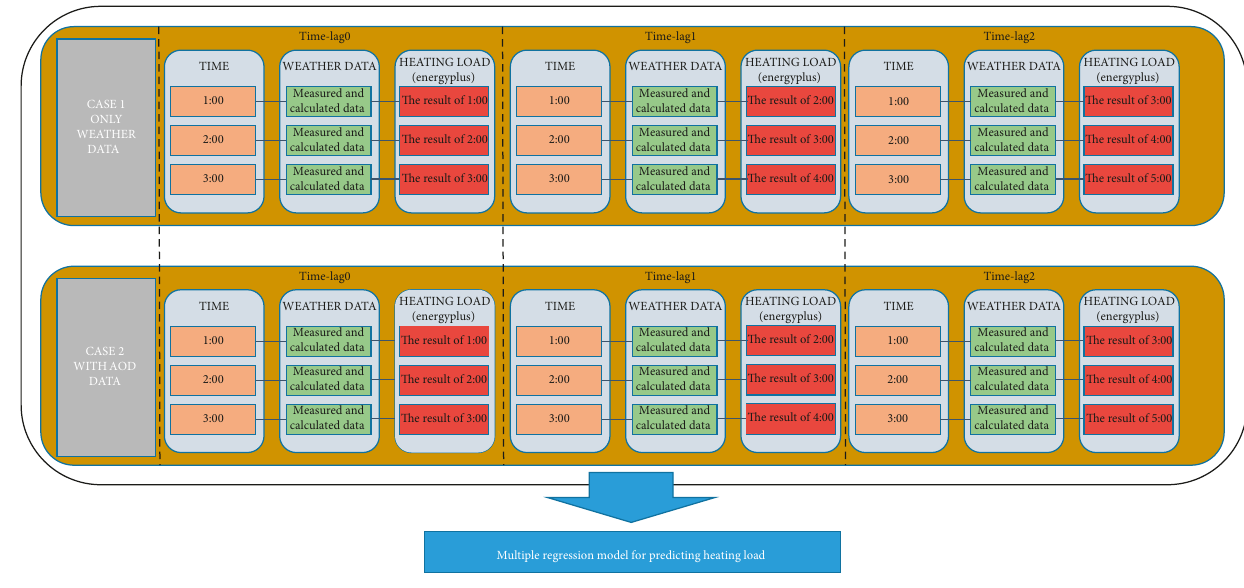
Figure 2: Study methodology workflow. Table 3: DOE small office model summary considering time-lag. Model summary a